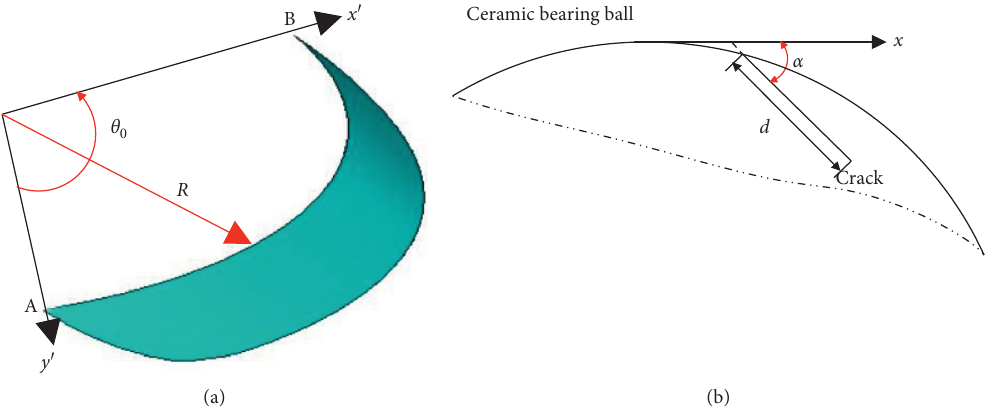
Figure 13: Crack schematic: (a) crack geometry; (b) the position of the crack.